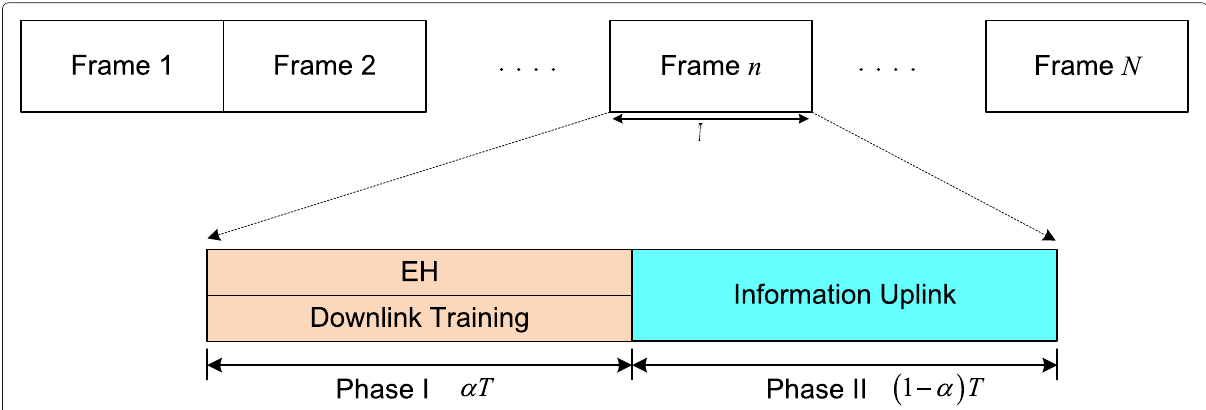
Fig. 3 Data frame structure of the proposed beam-domain SWIPT